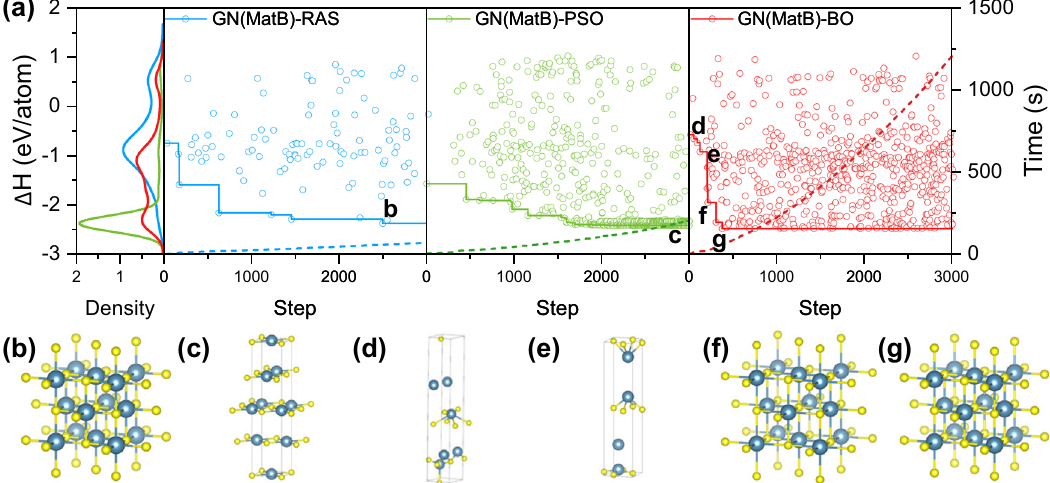
Fig. 3 The process and performance of GN-OA. a Process of GN(MatB)-RAS, GN(MatB)-PSO, and GN(MatB)-BO approaches, to search the crystal structure of CaS. The density of structures (DOS) at the energy level has been shown in the left panel. The computational cost has been added as the dashed lines. b – g Typical structures in the above process as shown in ( a ).